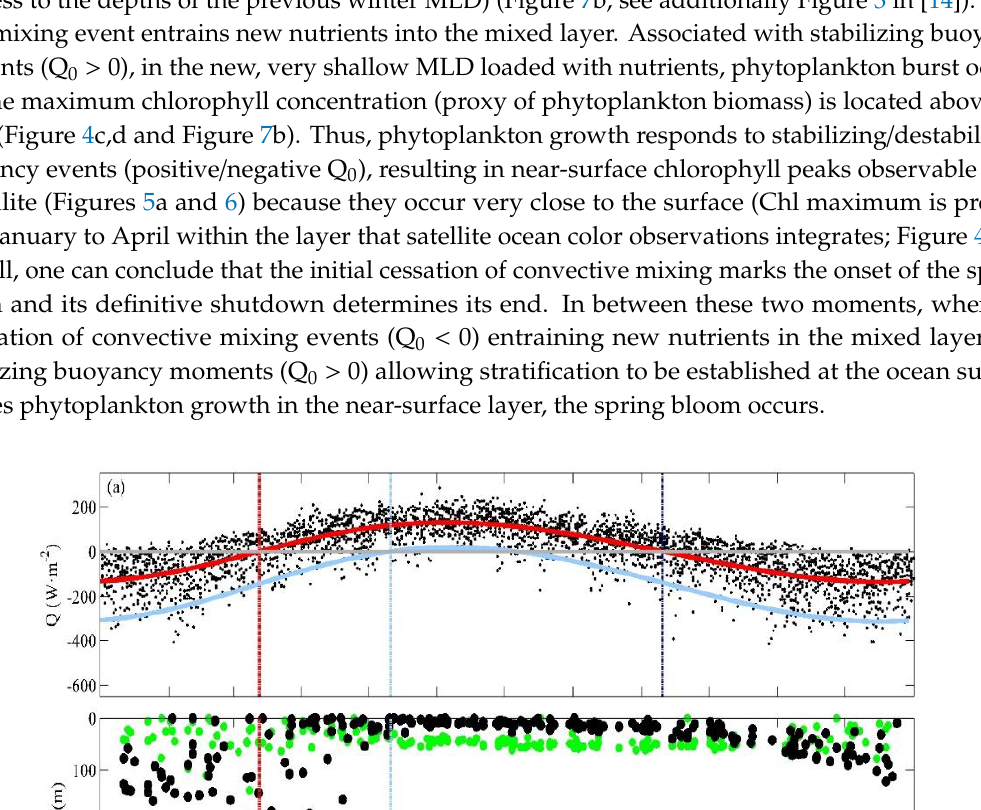
Figure 7. ( a ) Net heat flux (Q0) from the ocean to the atmosphere. All mean daily values registered since 2007 by the AGL buoy are shown (black dots). The climatological seasonal cycle obtained from these values is shown by the red line. The blue line shows the Q 0 − 2STD climatological cycle. ( b ) Depths of the Deep Chlorophyll Maximum (DCM) (green dots) and MLD (black dots) estimated on chlorophyll and density profiles registered at SATS oceanographic station. The vertical red line in ( a ) and ( b ) marks the date in which Q 0 climatological seasonal cycle becomes positive. Idem for the light blue line and the Q 0 − 2STD climatological seasonal cycle. The dark blue line in ( a ) marks the date at which Q 0 climatological seasonal becomes negative in late summer.